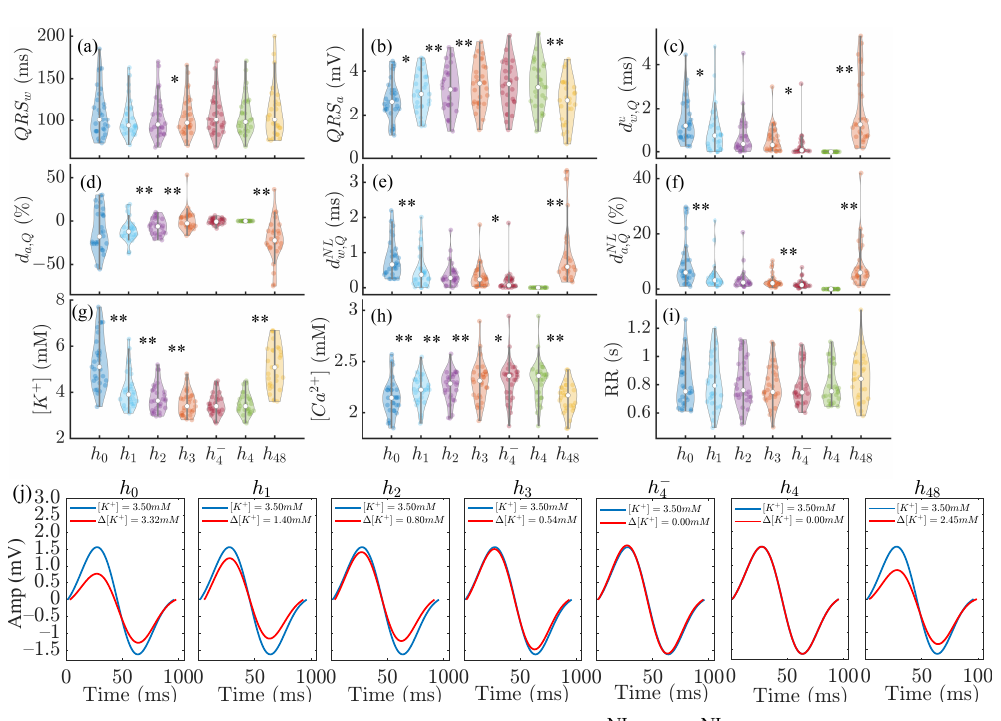
, d a,Q , d NL and d NL during HD stages. Panels w,Q w,Q a,Q